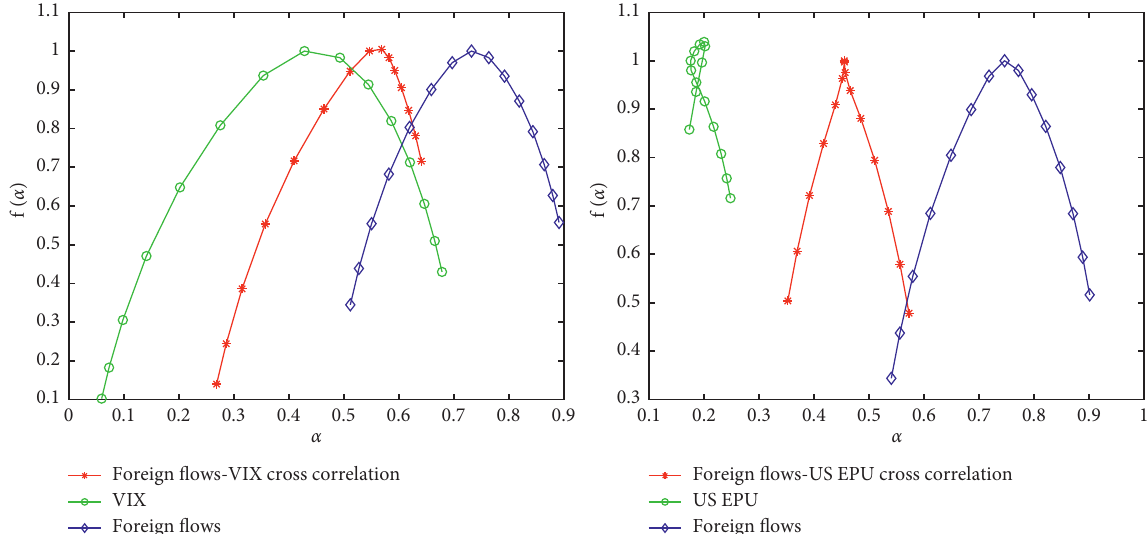
Figure 6: The multifractal spectrum f ( α ) versus α for the foreign flows in A-share market and VIX and the foreign flows in A-share market and US